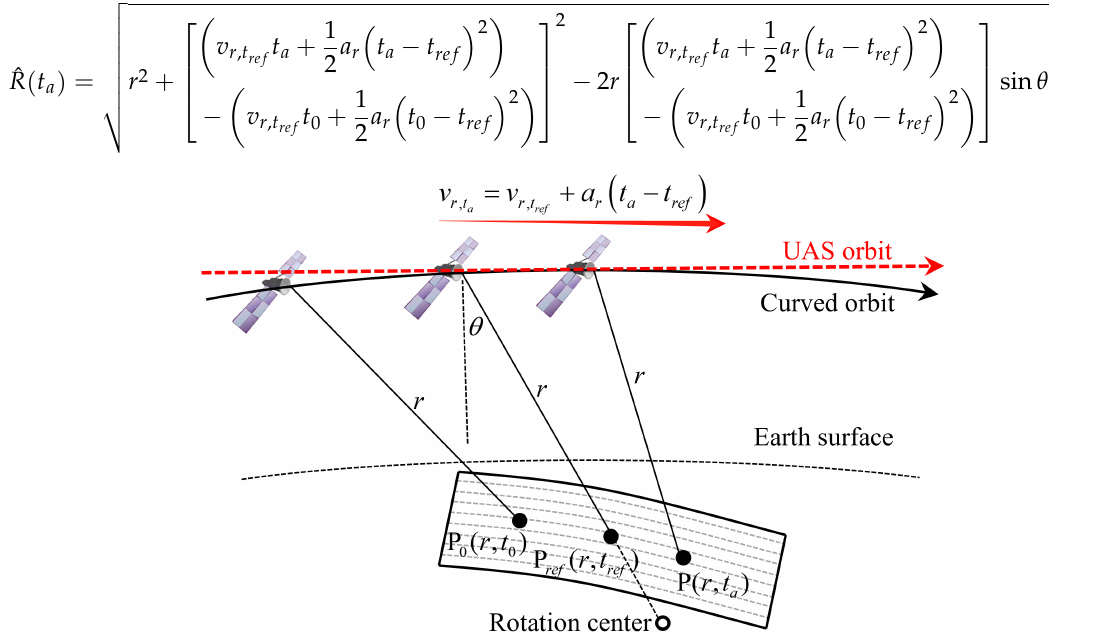
Figure 1. Observation geometry of squint spaceborne SAR with curved